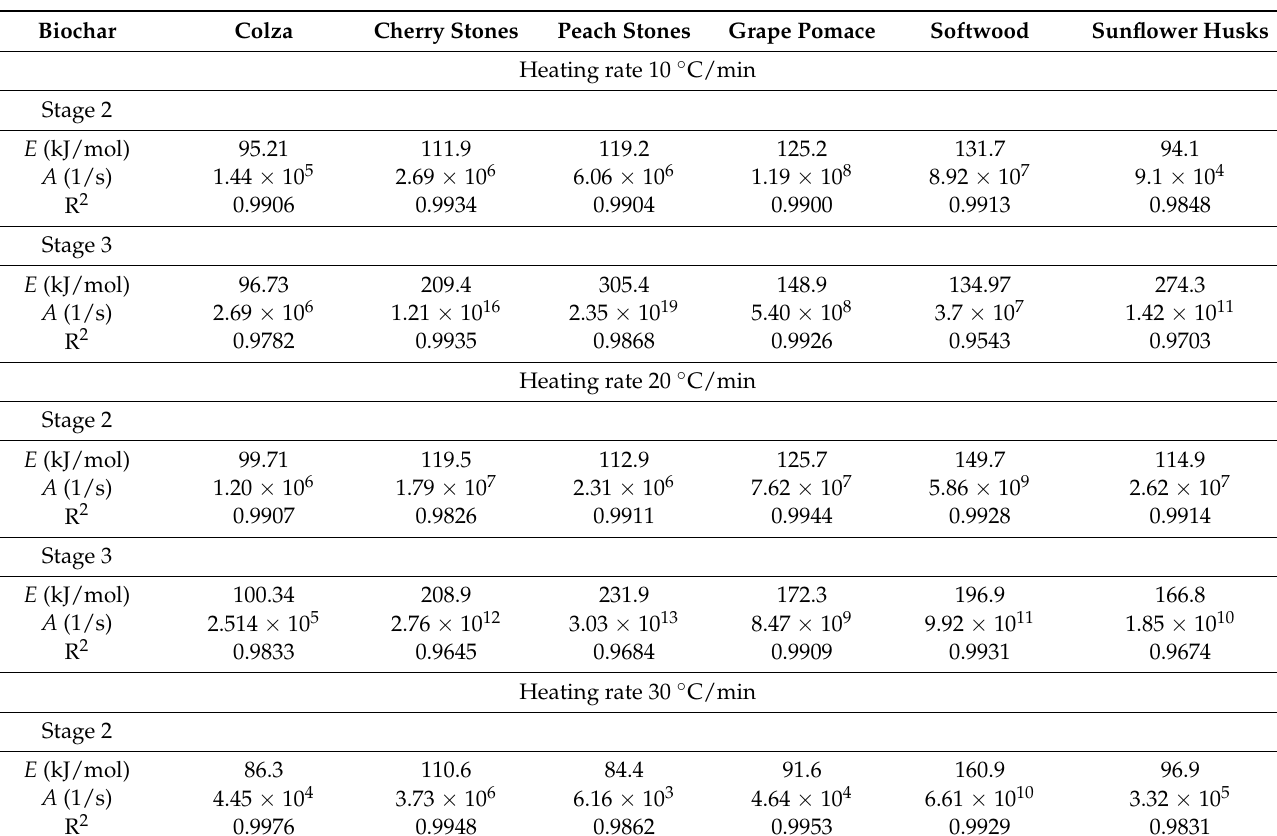
Table 3. Calculated kinetic parameters and correlation factor R 2